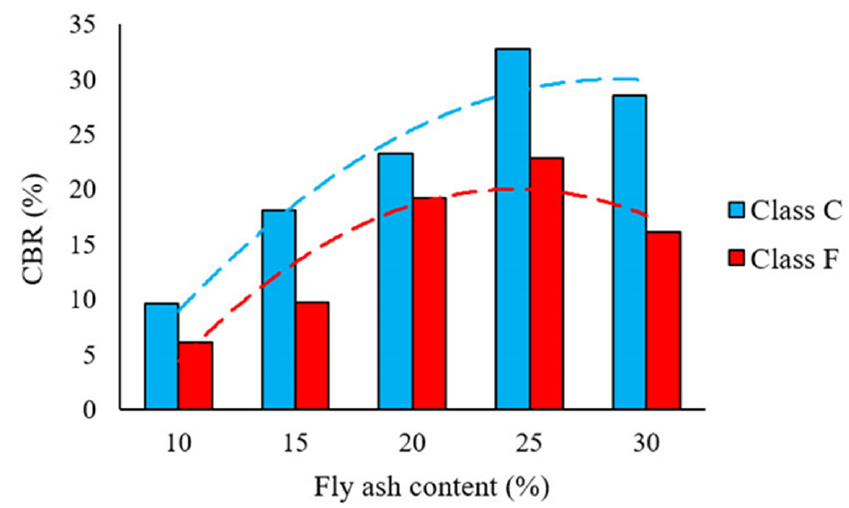
Figure 7. CBR variations when adding fly ash.